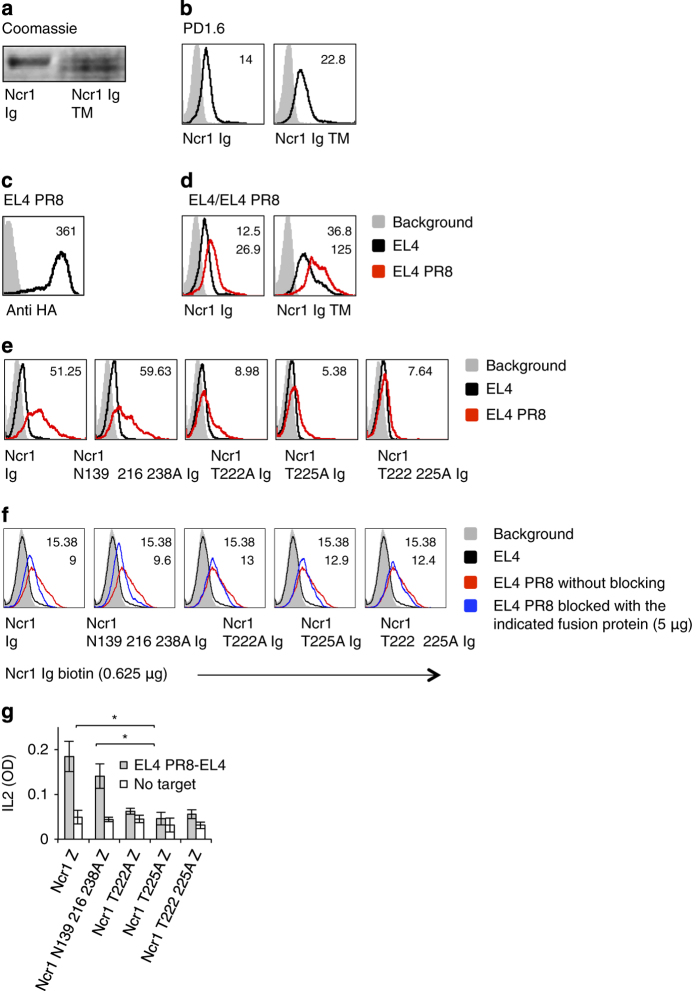
The O-linked glycosylations of Ncr1 are important for influenza virus HA recognition and function. (a) Coomassie staining of the indicated fusion proteins (5 μg) run on 10% SDS-PAGE gel under reducing conditions. Ncr1 Ig grown in medium containing tunicamycin is denoted Ncr1 Ig TM. Coomassie staining were adjusted for better clarity. (b) FACS staining of PD1.6 cells with Ncr1 Ig or with Ncr1 Ig TM. (c) Staining of PR8-treated EL4 cells with anti-HA1 mAb. (d) Untreated (black line histograms) or PR8-treated EL4 cells (red line histograms) were stained with Ncr1 Ig or with Ncr1 Ig TM (e). Untreated or PR8-treated EL4 cells were stained with each of the indicated WT or mutated Ncr1 Ig fusion proteins. (f) FACS staining of EL4 cells that were untreated or blocked with the indicated fusion proteins. The cells were then stained with biotinylated Ncr1 Ig. For all the FACS plots, the gray filled histograms are the backgrounds secondary mAb staining. The blocked or PR8-treated EL4 cells backgrounds were identical to the untreated cells therefore only the untreated cells background is shown). For all FACS plots, median fluorescent intensities (MFIs) of the fusion proteins staining are indicated. (g) IL2 levels secreted following incubation with the PR8-treated EL4 cells after subtraction of the untreated EL4 cells. Values are shown as mean ±s.e.m. *P<0.05. The entire figure represents data collected from three independent experiments of each assay.